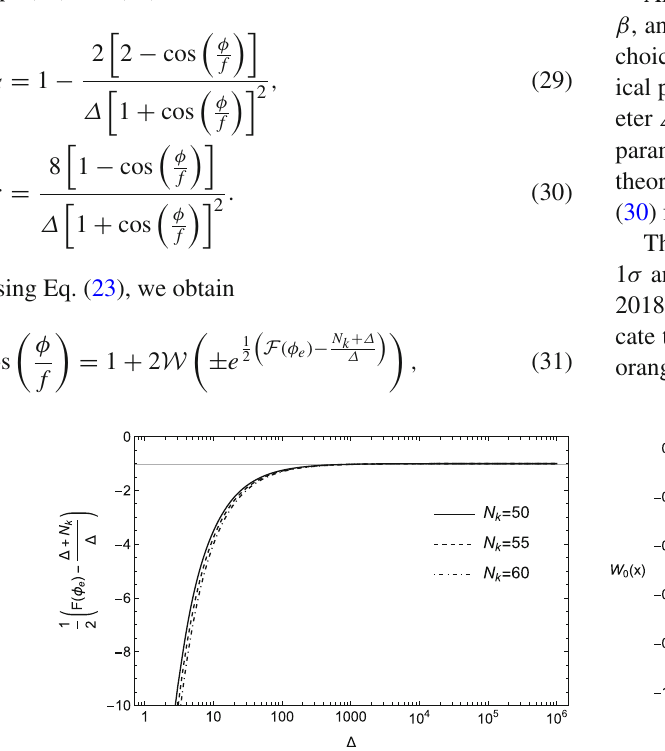
Fig. 1 Left: the exponent of an argument of W -function in Eq. (31) as a function of Δ and N k . The solid, dashed, and dot-dashed lines cor- respond to N k = 50, 55, and 60, respectively. The the exponent grows